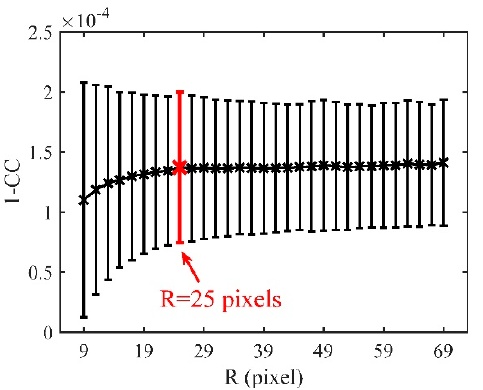
Figure 3. Influence of the side length of the subregion ( R ) on the correlation coefficient ( CC ) during the calculation of the DIC method. Crosses denote the mean value of 1 – CC , error bars indicate the standard deviations, and the cross and error bar in red correspond to the optimal subregion side length.